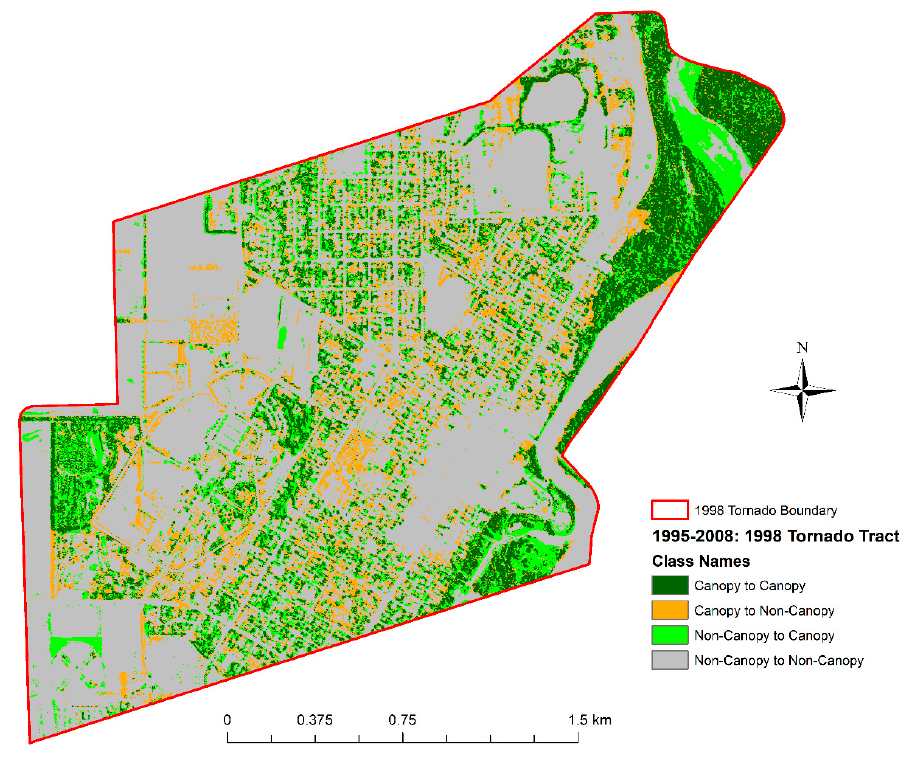
Figure 5. OBIA canopy cover change map 1995–2008: 1998 tornado tract.